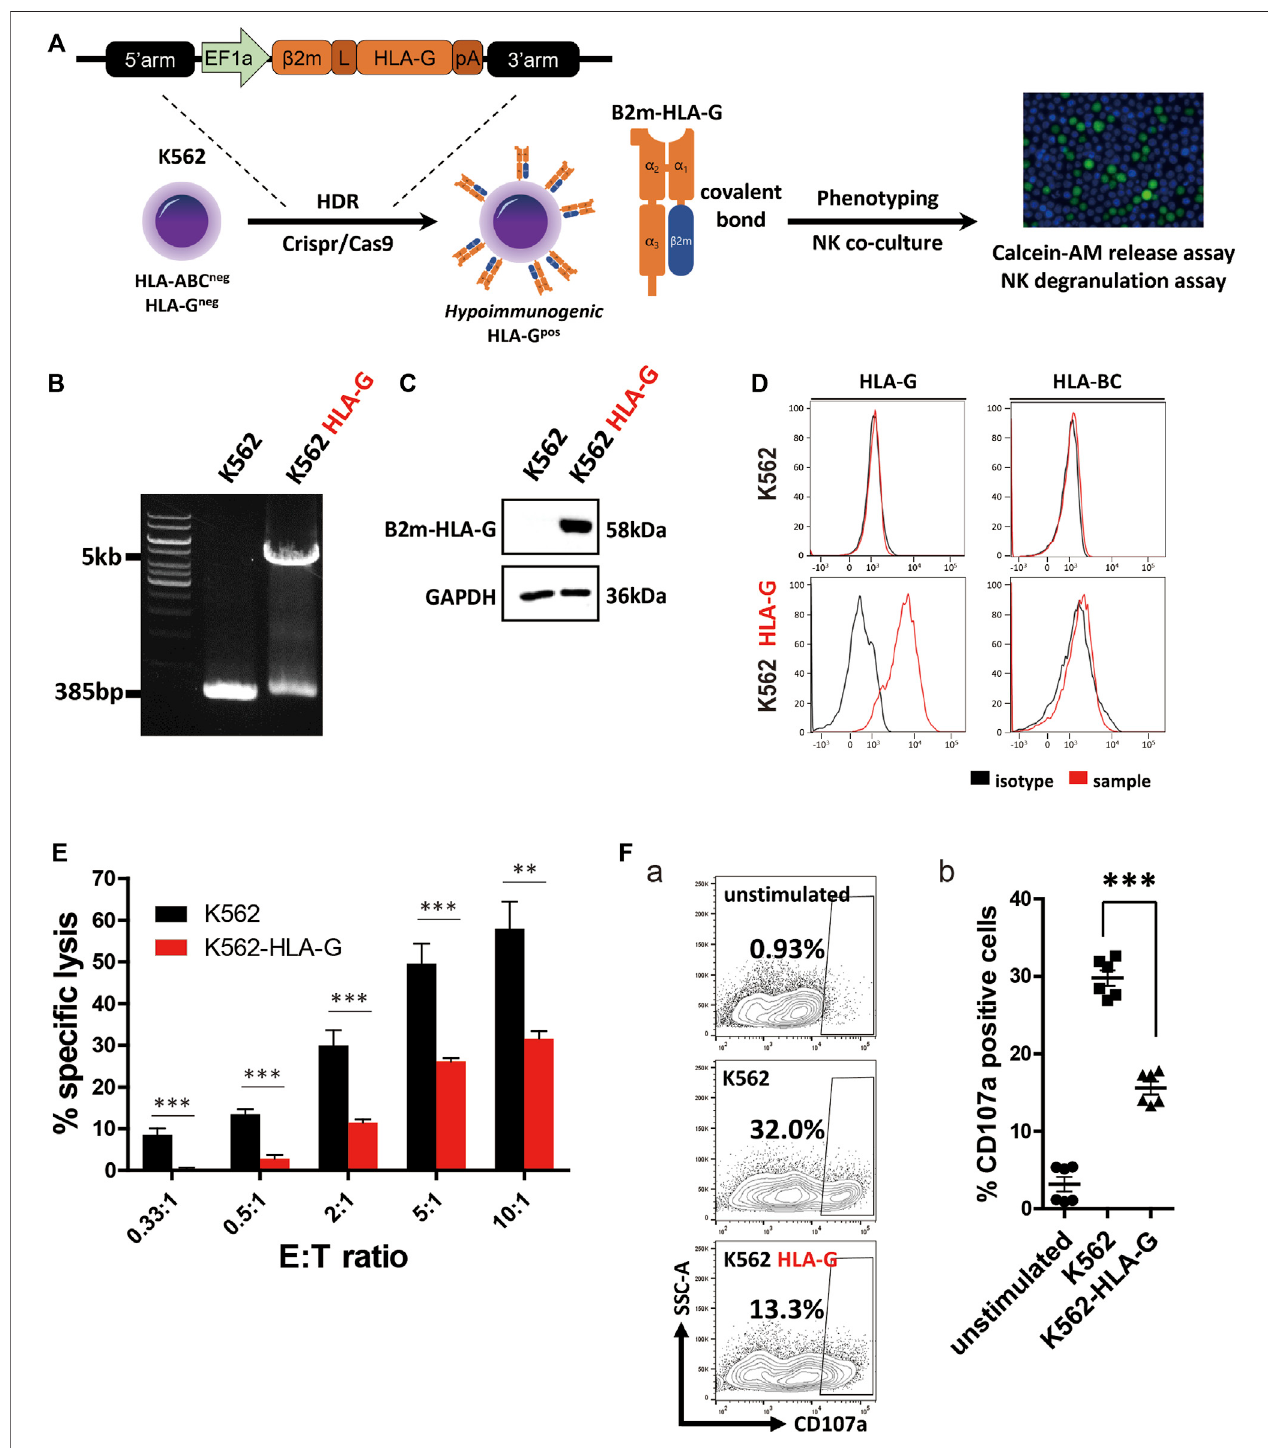
FIGURE1 | Generation ofan HLA-G-overexpressing K562cell line(K562-HLA-G) and evaluation ofits hypoimmunogenic activity. (A) Schematicof thegeneration of the hypoimmunogenic K562 cell line. (B) Genotyping of the HLA-G over-expressing K562 cell line by conventional PCR. (C) Covalently bound β 2m and HLA-G were con fi rmed by western blotting (D) Surface presentation of HLA-BC and HLA-G by fl ow cytometry (E) NK92 cells were less cytotoxic to K562-HLA-G cells than to WT K562 cells, according to calcein-AM release assays ( n = 4). (F) K562-HLA-G cells repressed NK degranulation. (a) NK cell degranulation at the indicated target cells.NKcelldegranulationmarker(CD107a)-positivecellsweregatedasshowninPanel (F) . (b) CD107a-positivepopulations( n =6).Dataaremeans±standarderrors of the mean (SEMs). * p < 0.05, ** p < 0.01, *** p < 0.001.